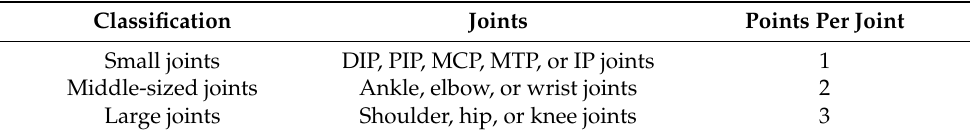
Table 1. Cumulative joint score classification.